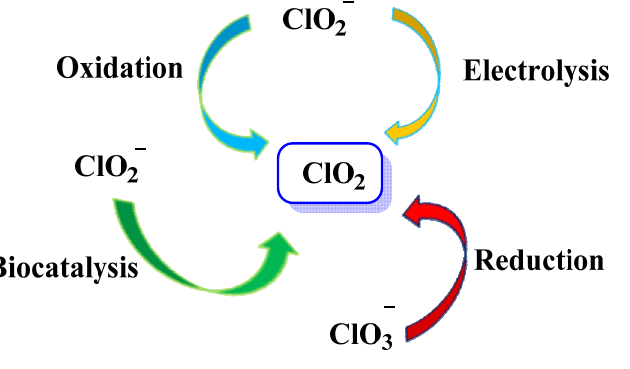
Figure 3. ClO 2 preparation methods.